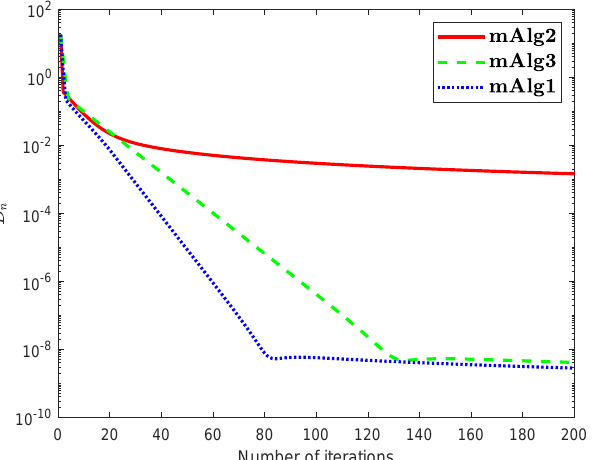
Figure 10. Algorithm 1 compared to Algorithm (60) and Algorithm 3.2 in [34] for u 0 = 1 + 3 t 2 + cos ( t )